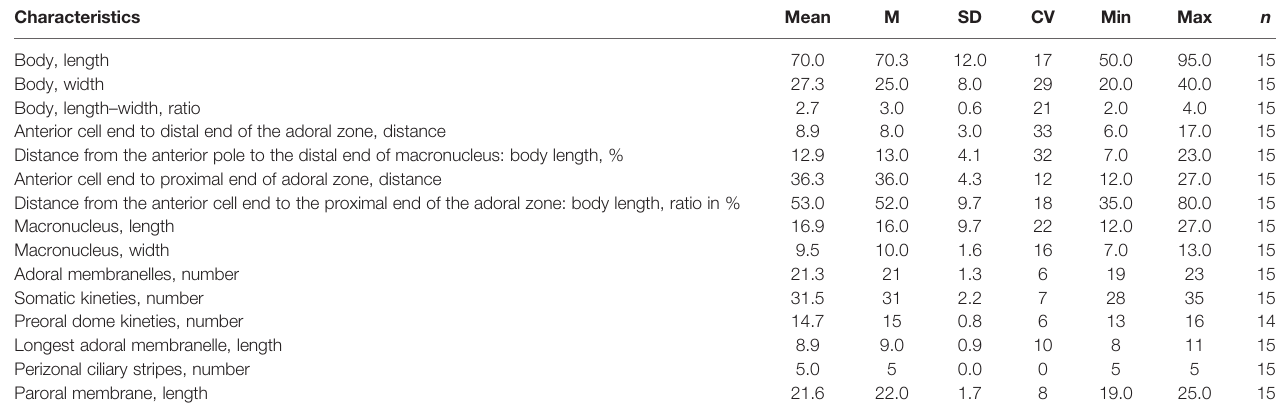
TABLE 3 | Morphometric characteristics of Metopus parapellitus sp. n. based on protargol-stained specimens. Measurements in m m. Characteristics Body,